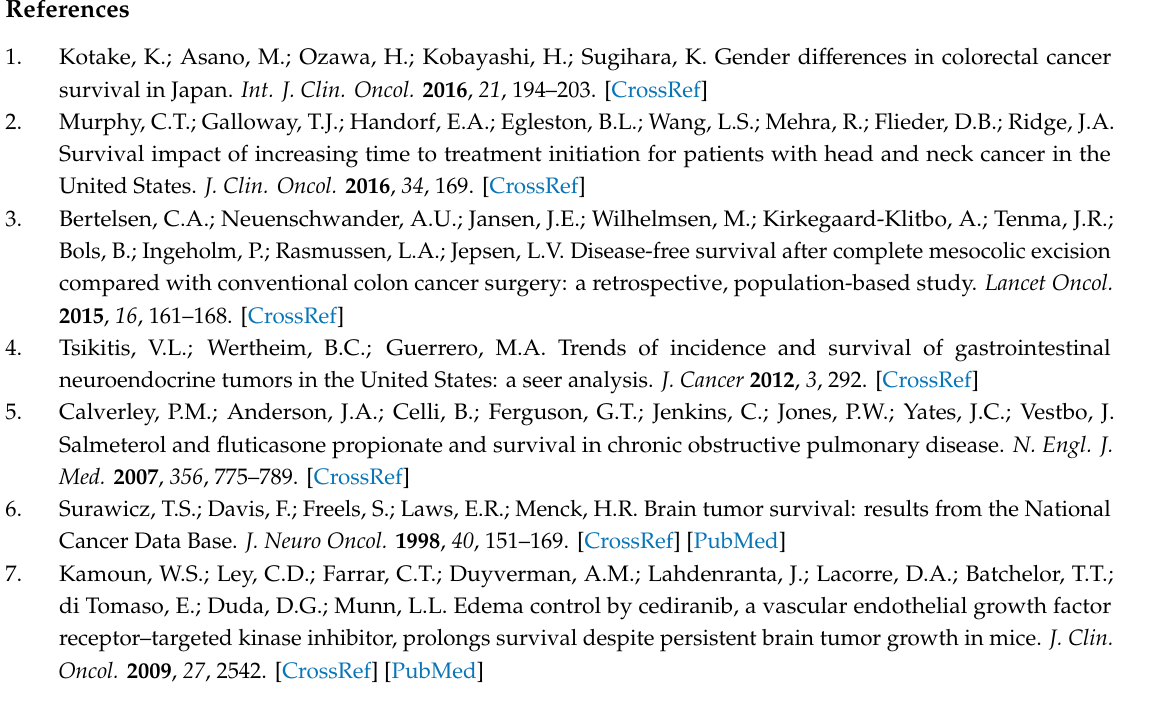
Figure S7: Visualization of an example of marital status (married) for the time interval 1911–1920 and each location; Table S1: Data analysis: sample size for each time interval and location; Table S2: Data analysis: estimated coe ffi cients and standard deviations using the proposed approach; Table S3: Data analysis: estimated coe ffi cients and standard deviations using the separate estimation; Table S4: Data analysis: estimated coe ffi cients and standard deviations by pooling all time intervals and locations; Table S5: Data analysis: estimated coe ffi cients and standard deviations by pooling all locations; Table S6: Data analysis: estimated coe ffi cients and standard deviations by pooling all time intervals; Table S7: Simulation I: mean squared errors (MSE) and variance (Var) of the proposed and separate estimations; Table S8: Simulation II: mean squared errors (MSE) and variance (Var) of the proposed and separate